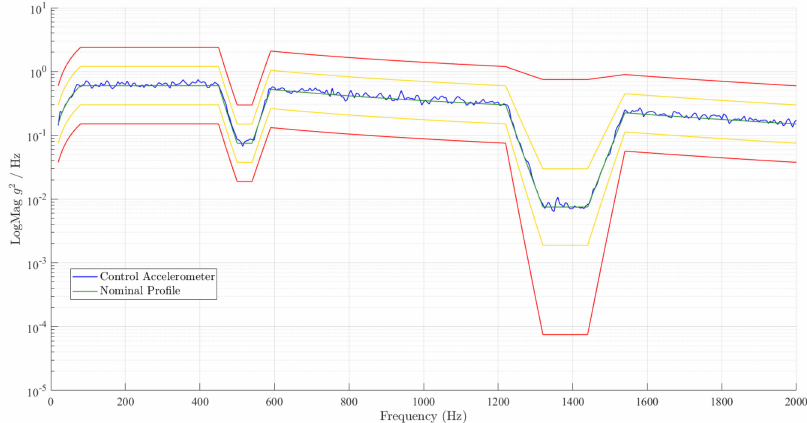
Figure 19. Notching profile.